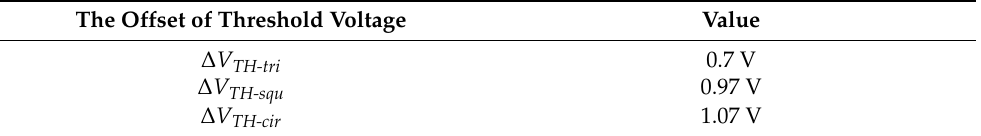
Table 4. The offset of threshold voltage of three types of SiNWs-FET